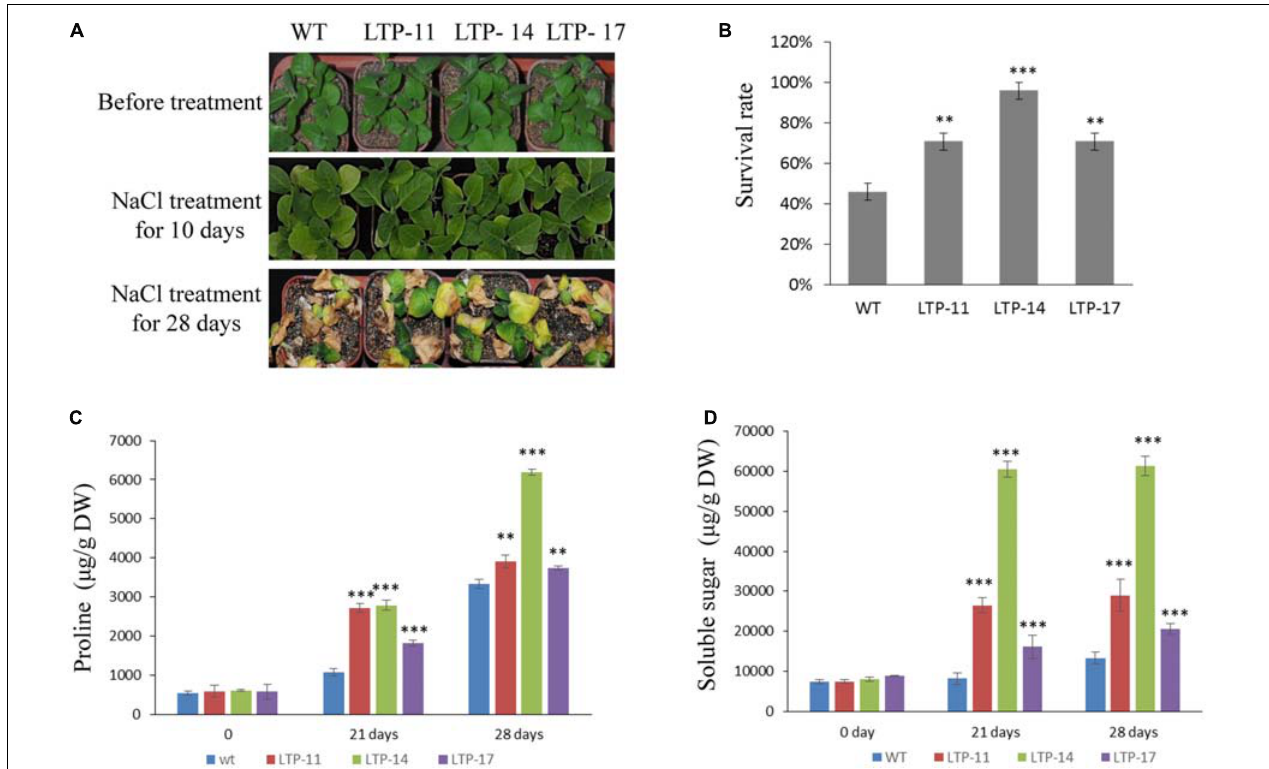
FIGURE 6 | Salt resistance analysis of T1 transgenic and WT tobacco seedlings. Four-week-old seedlings of the transgenic lines and WT were irrigated for 0, 10, and 28 days with 250 mM NaCl (A) ; the survival rates of transgenic and WT seedlings after watering for 28 days with NaCl (B) ; the proline content (C) ; and soluble sugar content (D) were analyzed in transgenic and WT plants after watering for 21 and 28 days with NaCl, respectively. Six seedlings of each transgenic line and WT were planted in each small basin for the NaCl treatment and corresponding analysis; 18 plants were used in each experiment. ∗∗ and ∗∗∗ indicate statistically significant differences at P < 0.01 and P < 0.001 (Student’s t -test),